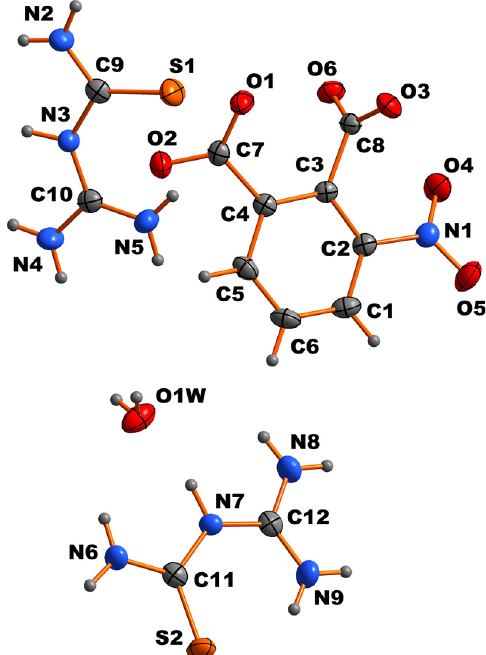
Table  : Data collection and handling.